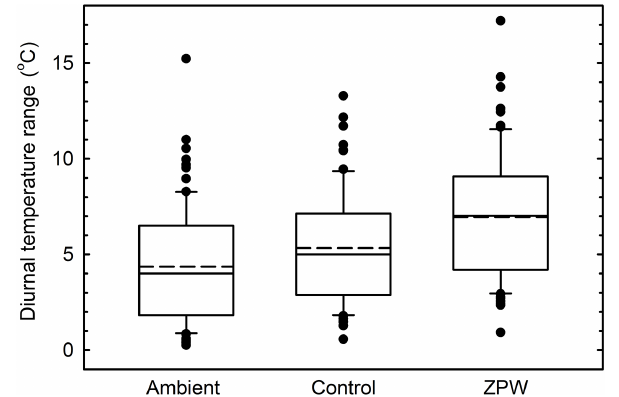
Figure 7. Tukey box plots showing the mean daily diurnal temper- ature range in the ambient plot and the control and ZPW cham- bers. The diurnal temperature range was calculated for each day by subtracting the minimum temperature from the maximum temper- ature recorded on a given day. Data from DOY 190, 191, 195 and 196 were omitted due to chamber manipulations. Box plots show the interquartile range (box), median (solid line) and mean (bro- ken line). The whiskers show lowest and highest datum still within 1.5 × interquartile range of the lower and upper quartiles. Outliers are shown as black dots.